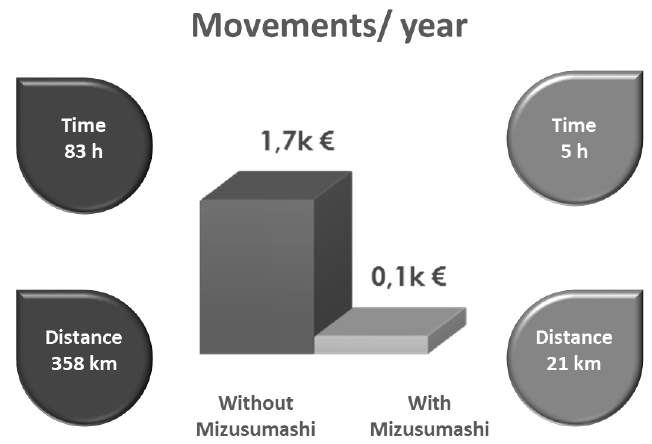
Figure 9. Gains from the implementation of the Mizusumashi .